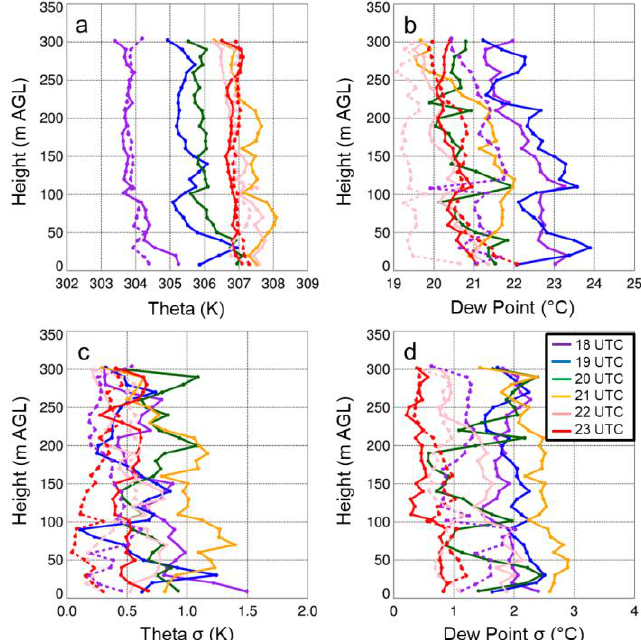
Figure 11. Vertical profiles of potential temperature (i.e., theta) ( a ) and dew point ( b ) as a function of height for select sUAS flights with the DJI S-1000 (solid) and MD4-1000 sUAS (dashed) on 14 August 2017. Panels ( c ) and ( d ) show the standard deviation ( σ ) in potential temperature and dew point, respectively. Purple, blue, green, orange, pink, and red lines coincide with flights made starting at 1800 UTC, 1900 UTC, 2000 UTC, 2100 UTC, 2200 UTC, and 2310 UTC, respectively. Data were binned every 10-m